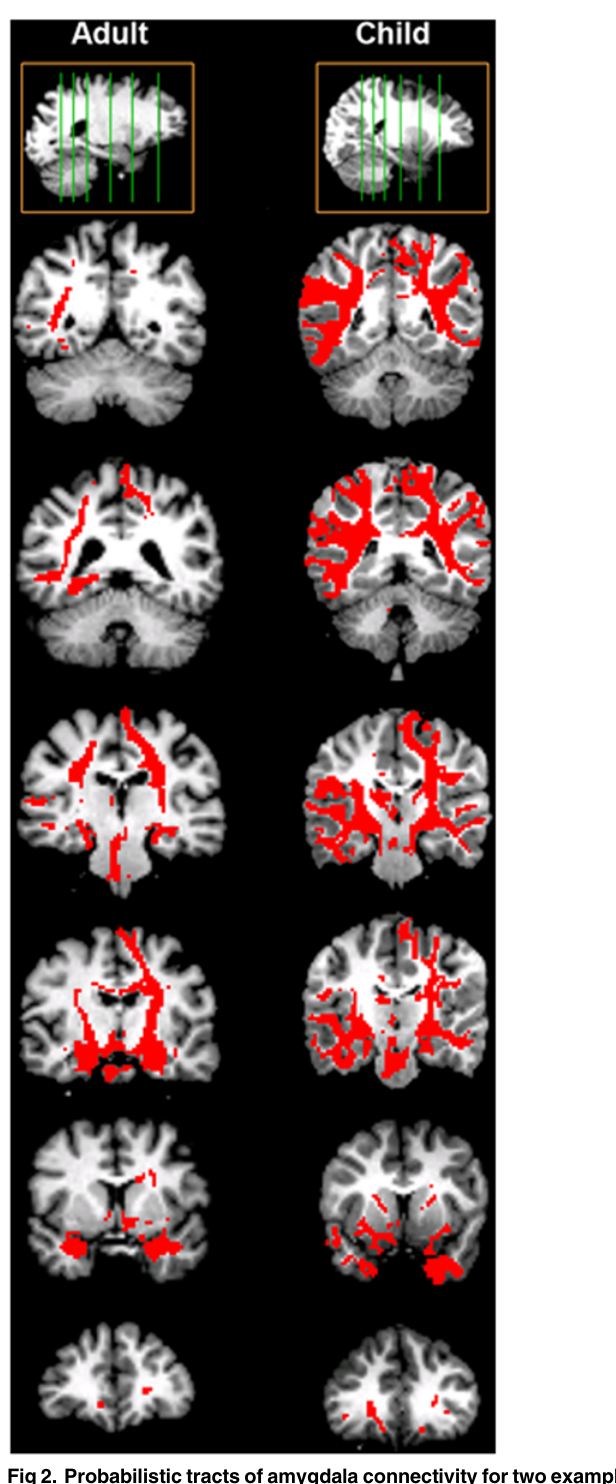
Fig 2. Probabilistic tracts of amygdala connectivity for two example subjects. Probability maps are thresholded at 0.1 of maximum connection probability for each subject and overlaid on the same subject ’ s low-b diffusion image. These depict all possible tracts that the tractography algorithm used to connect the left and right amygdalae with all other target regions (i.e. the rest of the brain). Top images are the sagittal sections showing the slice locations for the coronal sections below for the adult subject (left column) and